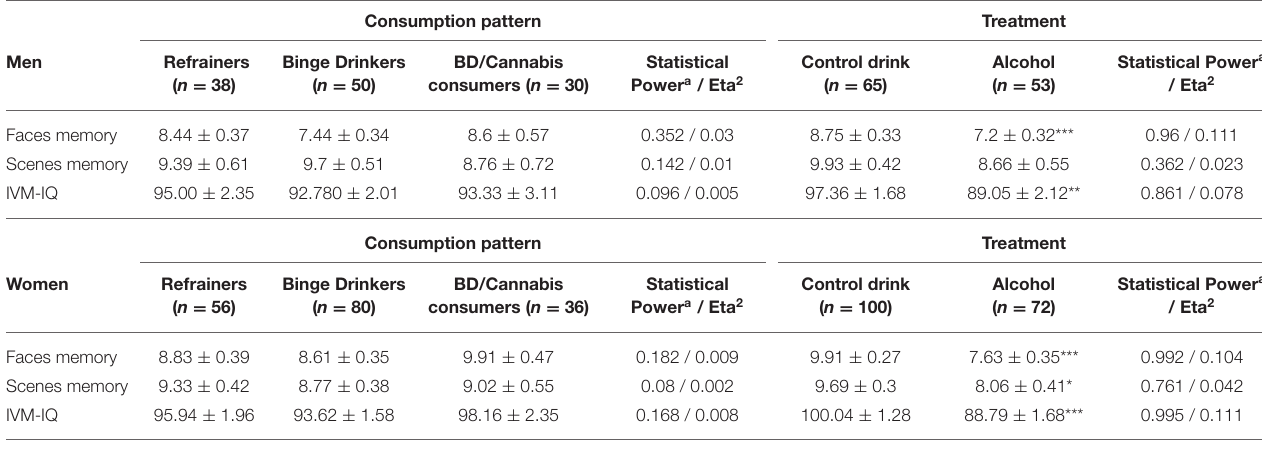
TABLE 1 | Descriptive statistics for consumption pattern and treatment factors and significant differences observed in faces memory, scenes memory and IVM-IQ in men and women. Consumption pattern